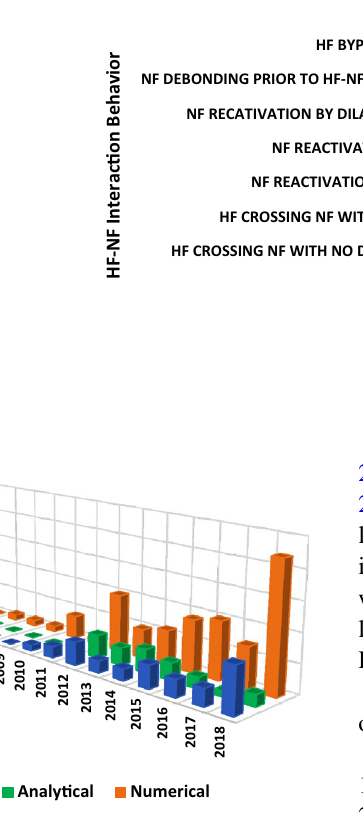
Fig. 3 Bar graph showing number of published articles between 1963 and 2019. This chart shows variations in methods of approach over